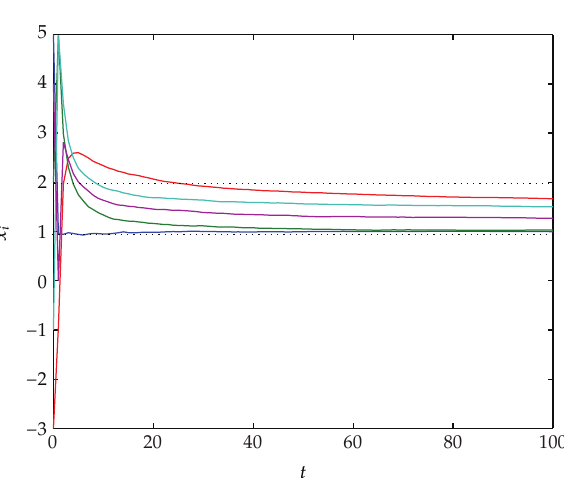
Figure 2: The state trajectories of the agents. The solid and dotted lines denote, respectively, the trajectories of the followers and the leaders.